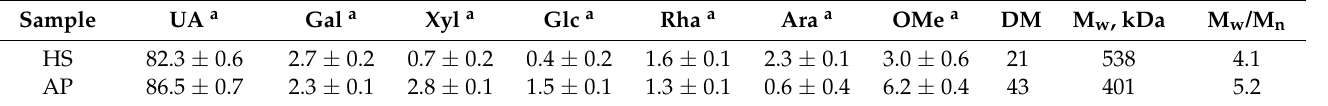
Table 5. Chemical characteristics of